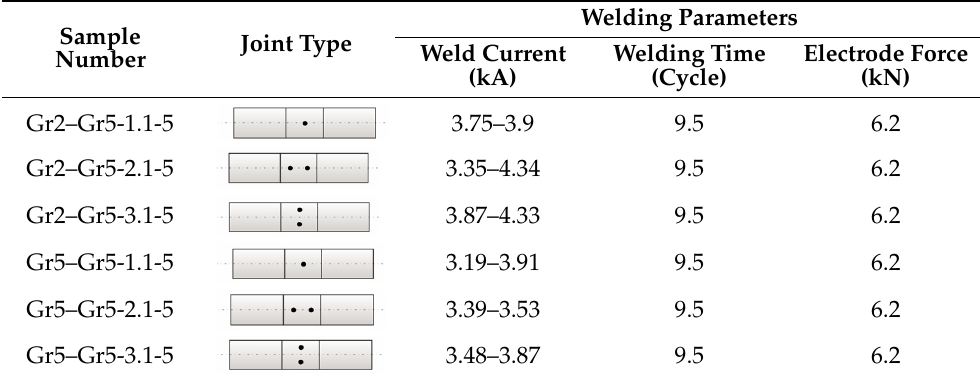
Table 4. Welding parameters Gr2–Gr5 and Gr5–Gr5 joints. Sample Number